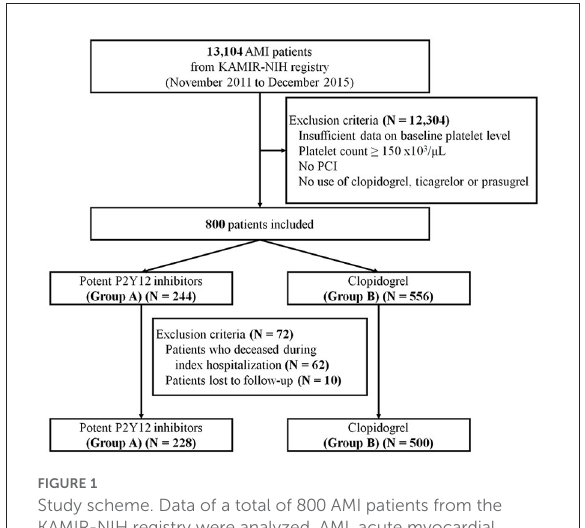
FIGURE1 Study scheme. Data of a total of 800 AMI patients from the KAMIR-NIH registry were analyzed. AMI, acute myocardial infarction; KAMIR-NIH, korea acute myocardial infarction registry-national institutes of health; PCI, percutaneous coronary